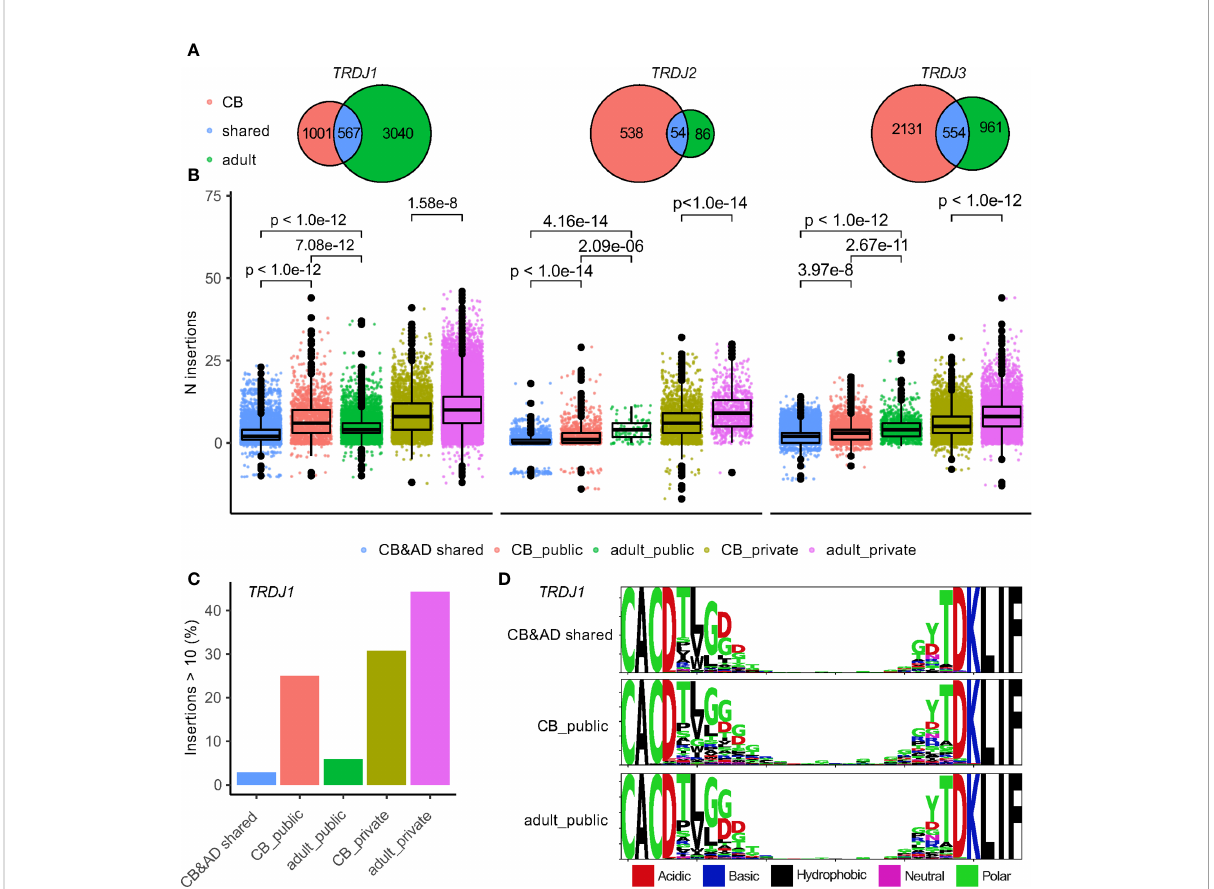
FIGURE 3 Patterns of public clones alter between age groups. (A) Venn plots show the overlap of public V d 2 + clones between CB and adult groups. The sizes of ellipses correlate to number of unique clones. (B) N-insertion of V d 2 + TCRs in corresponding groups. Each point stands for a CDR3 nucleotide sequence. The distribution is summarized by box plot; the three horizontal lines of the box-whisker plot represent the higher quartile, median, and lower quartile, respectively. Games-Howell test was used for P-value calculation. V d 2 + TCRs were grouped by J-usage and the publicity between CB and adult. (C) barplot shows the ratio of sequences with N insertions ≥ 10 in publicity groups with TRDJ1 gene usage. (D) Logomap for sequences with public TRDJ1 gene